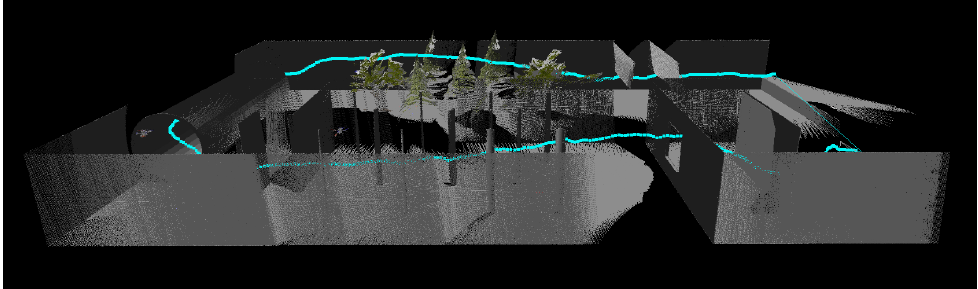
Figure 26. Visualization of the trajectory of UAV controlled by the SCAN algorithm (Area 1, Area 2, and Area 3), side